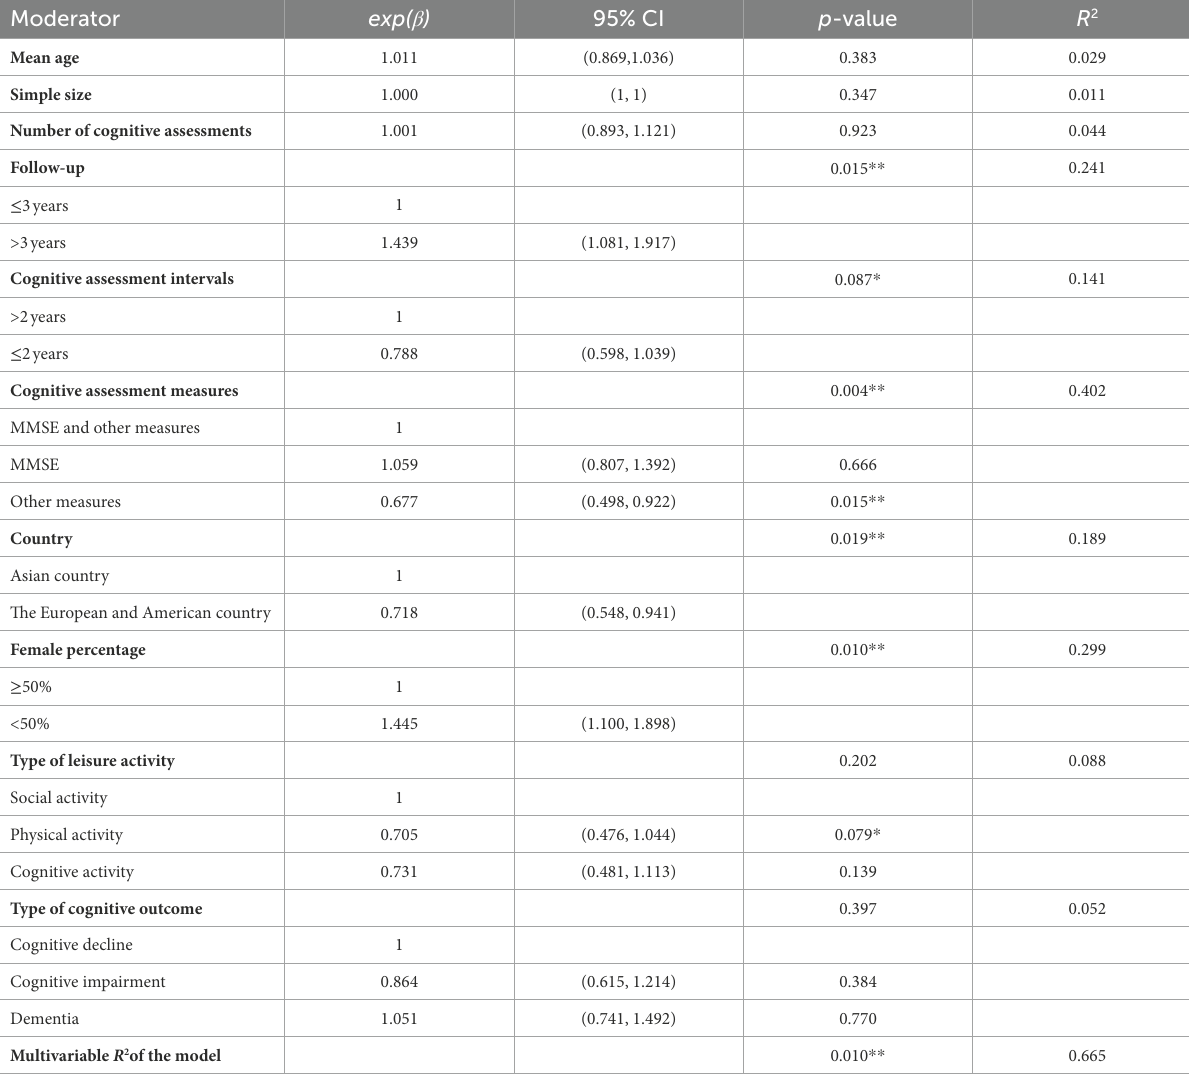
TABLE 2 Meta-regression of exploring factors contributing to heterogeneity in the relative